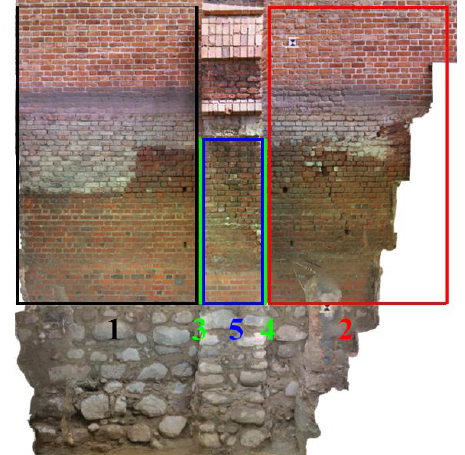
Figure 3. Marked tested areas on the orthoimages from all of the epochs